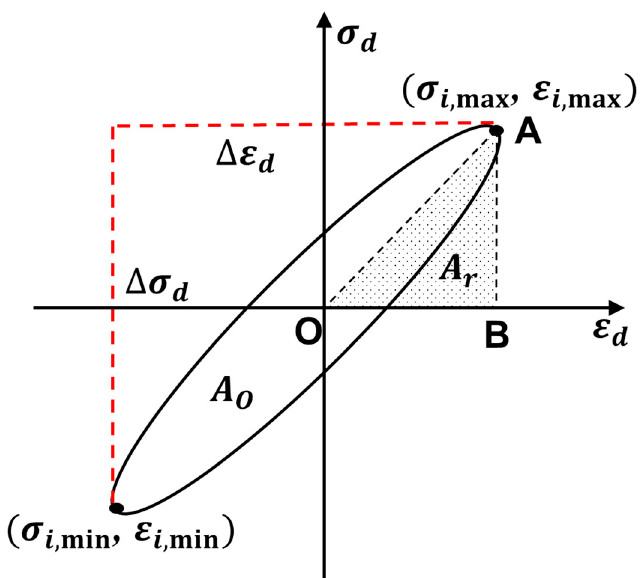
Figure 5. Schematic diagram of the typical hysteresis